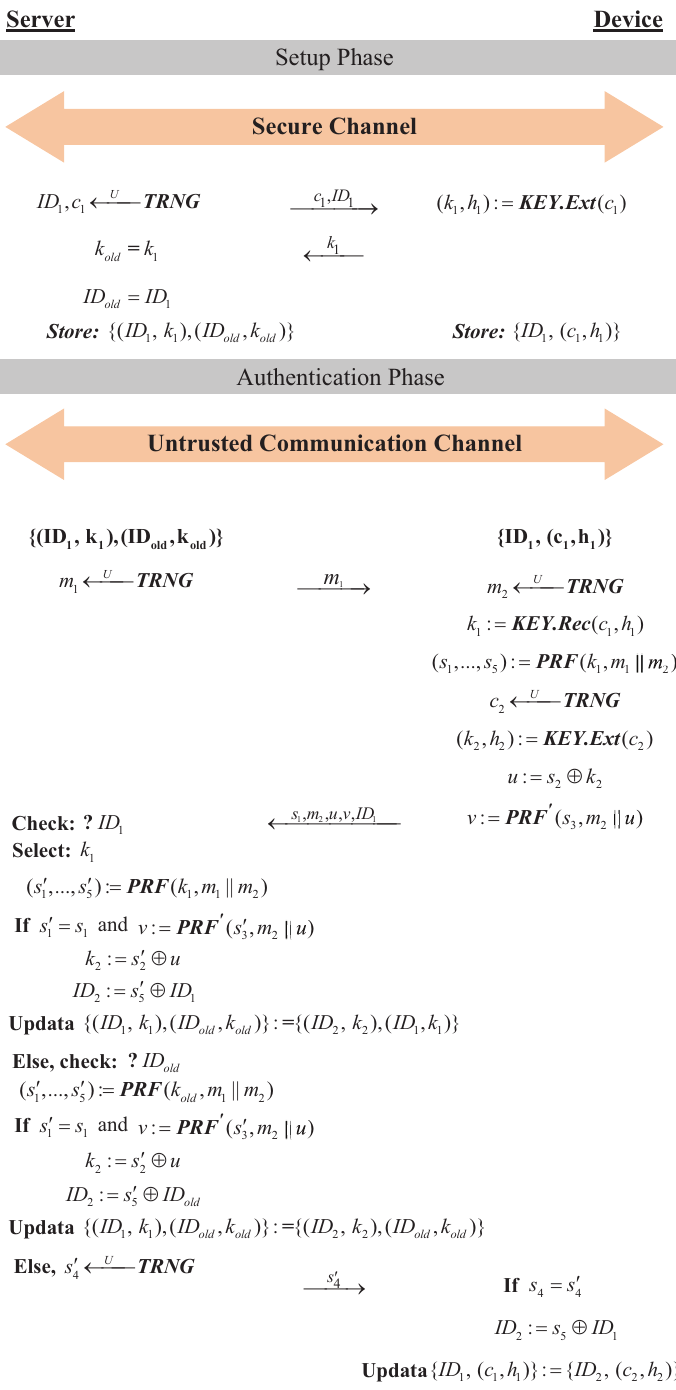
Figure 5. The proposed